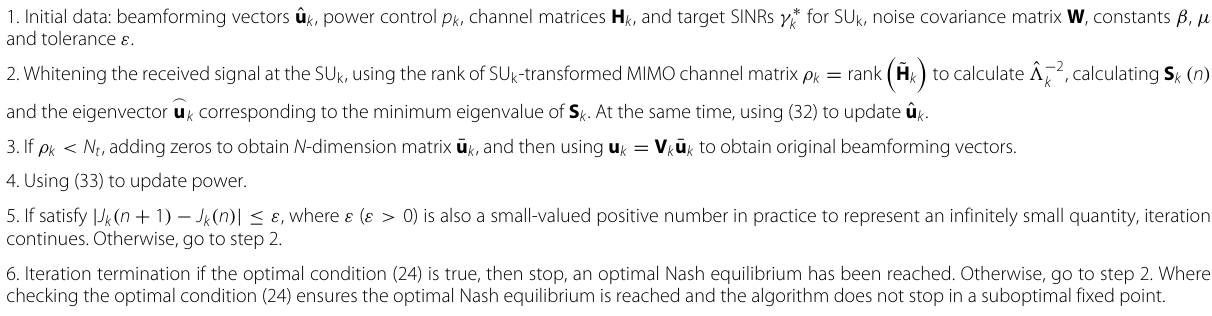
for SU k , noise covariance matrix W , constants β , μ k